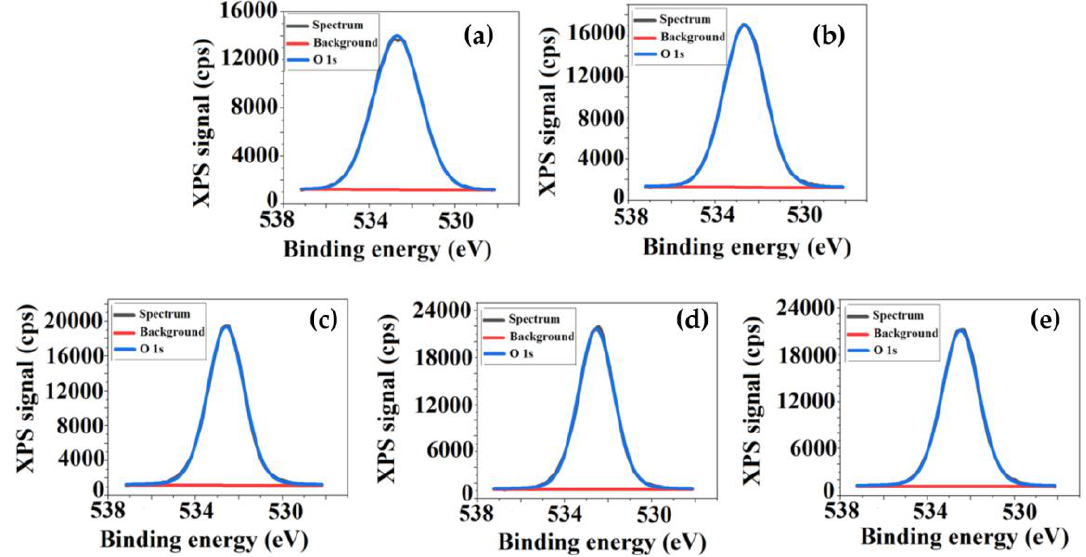
Figure 6. The deconvolution of O 1s spectra for: ( a ) CA, ( b ) CA+0.5 wt.% TEOS, ( c ) CA+1.0 wt.% TEOS, ( d ) CA+1.5 wt.% TEOS, ( e ) CA+2 wt.% TEOS films.